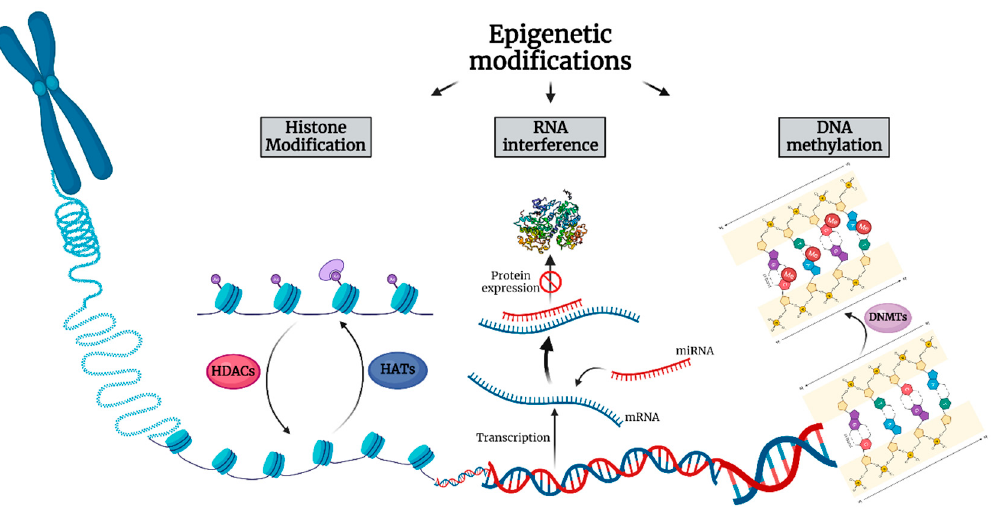
Figure 1. The three main mechanisms of epigenetic alterations comprised of histone acetylation, protein expression obstruction through RNA interference and DNA methylation. HDAC: Histone deacetylase, HAT: Histone acetyltransferase, DNMT: DNA methyltransferase.